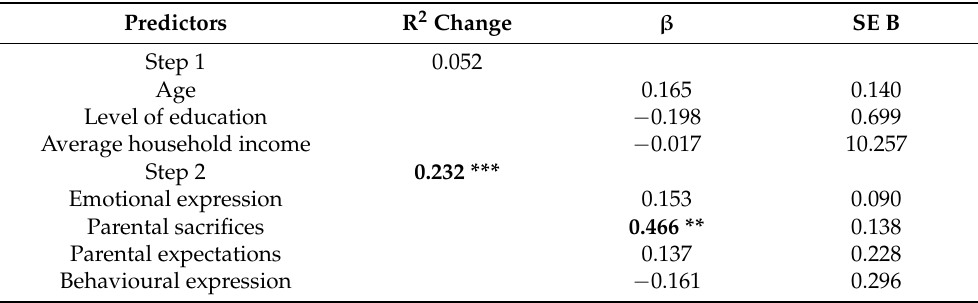
Table 3. Multiple regressions of sociodemographic information, parental stress, and depressive